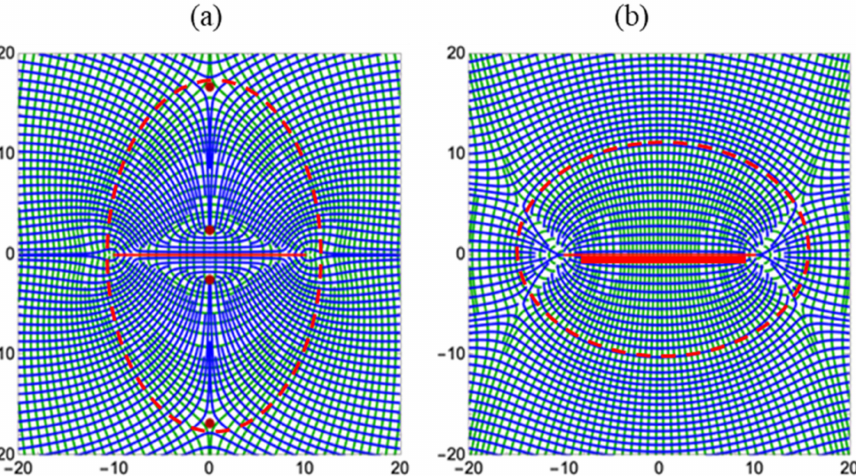
Figure 8. Stress trajectory solutions for hydraulic fracture (solid red bar). ( a ) Stress cage (dashed red upright ellipse) for PNET = +20 MPa. ( b ) Fracture cage (dashed red horizontal ellipse) for PNET = − 20 MPa. A far-field anisotropic stress field is present, with the largest compressional principal stress trajectories outlined in blue and the least principal stress trajectories outlined in